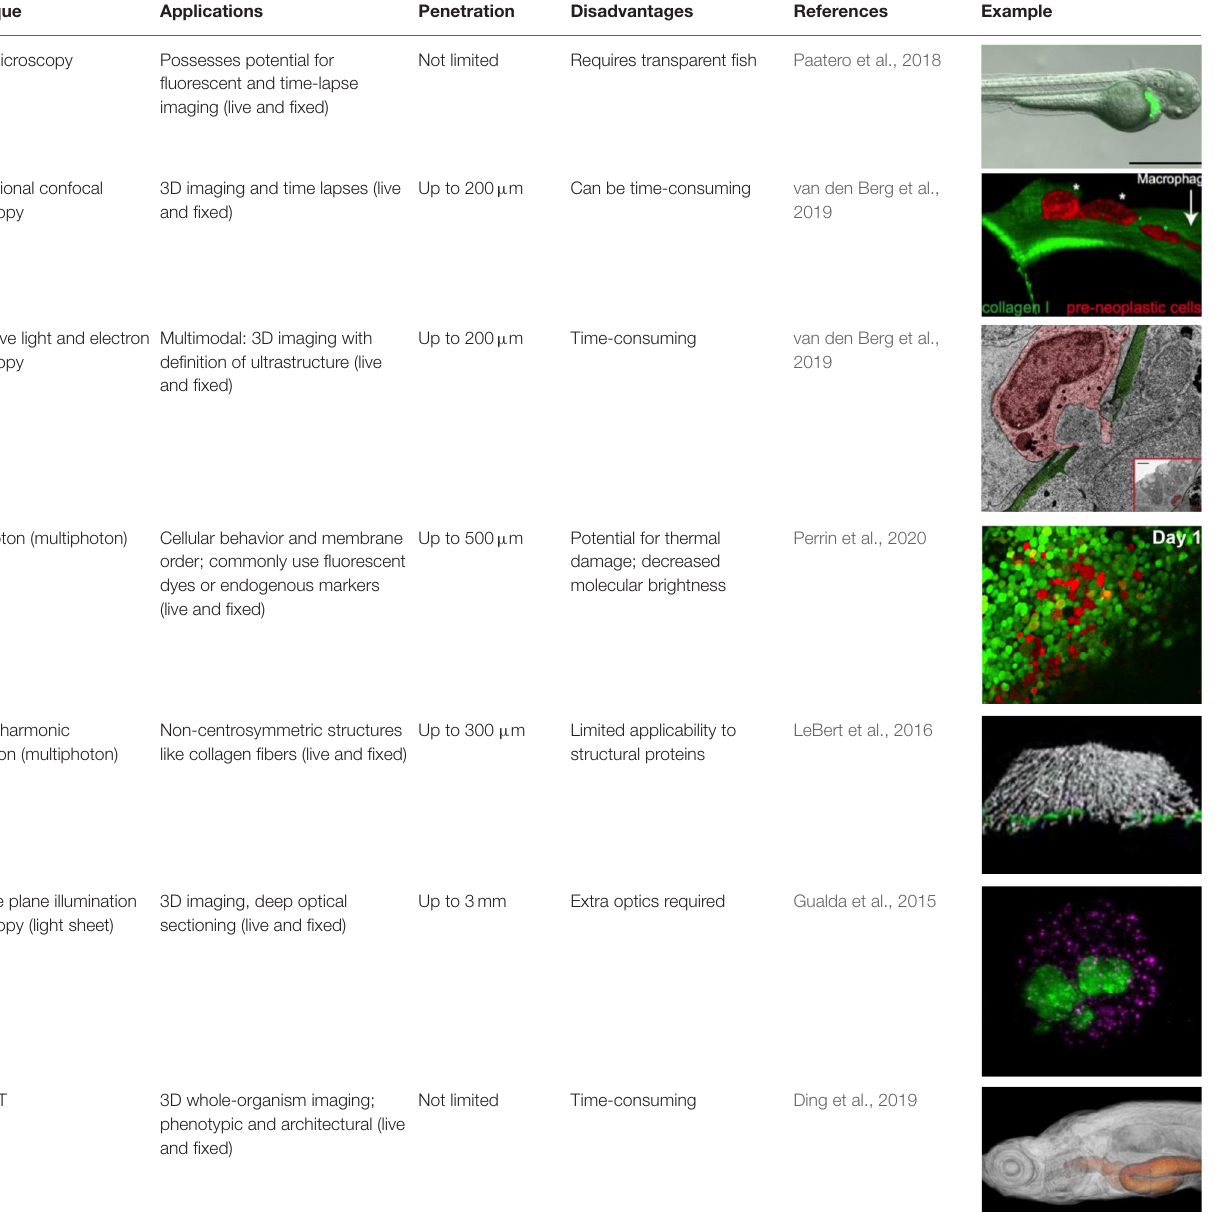
TABLE 1 | Employable imaging techniques for the investigation of TME interactions in